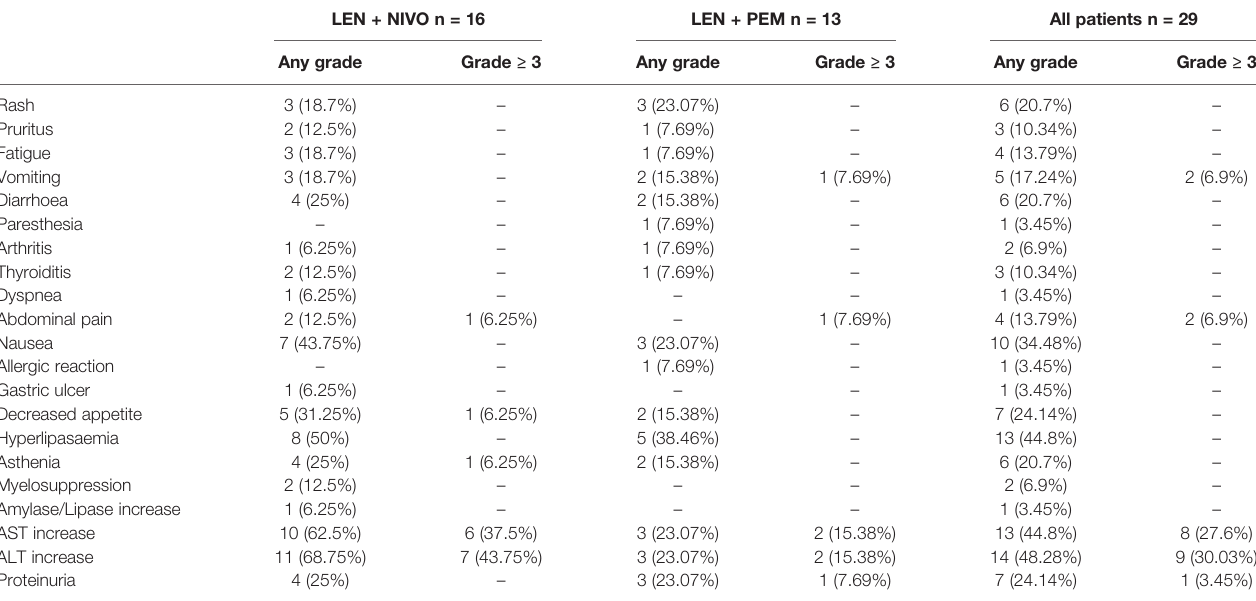
TABLE 3 | Adverse